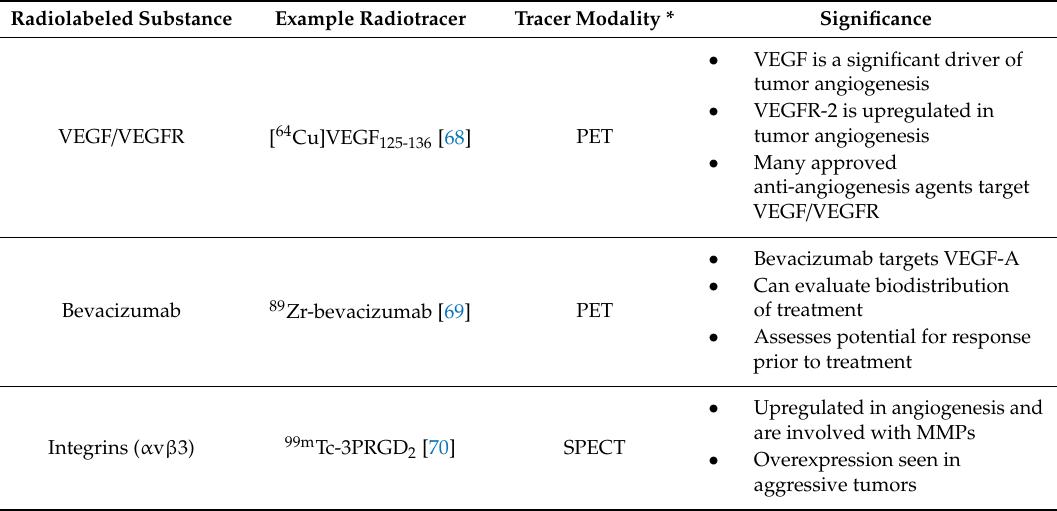
Table 2. Molecular targets in molecular imaging of